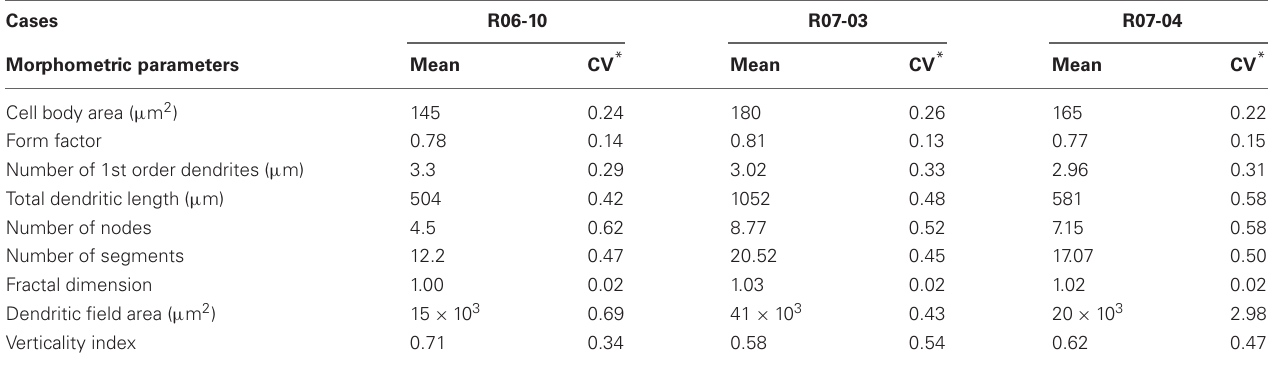
Table 2 | Morphometric parameters of nitrergic neurons per hemisphere.